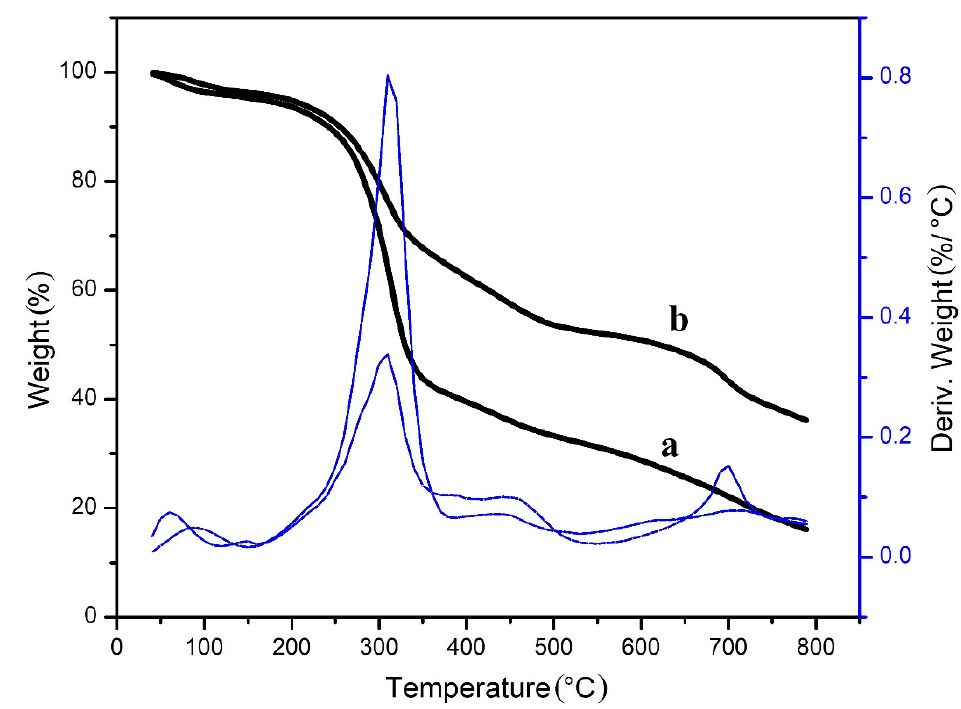
Figure 3. TGA thermograms of ( a ) CQVP/MA and ( b ) CQVP/MA-Fe 3 O 4 .